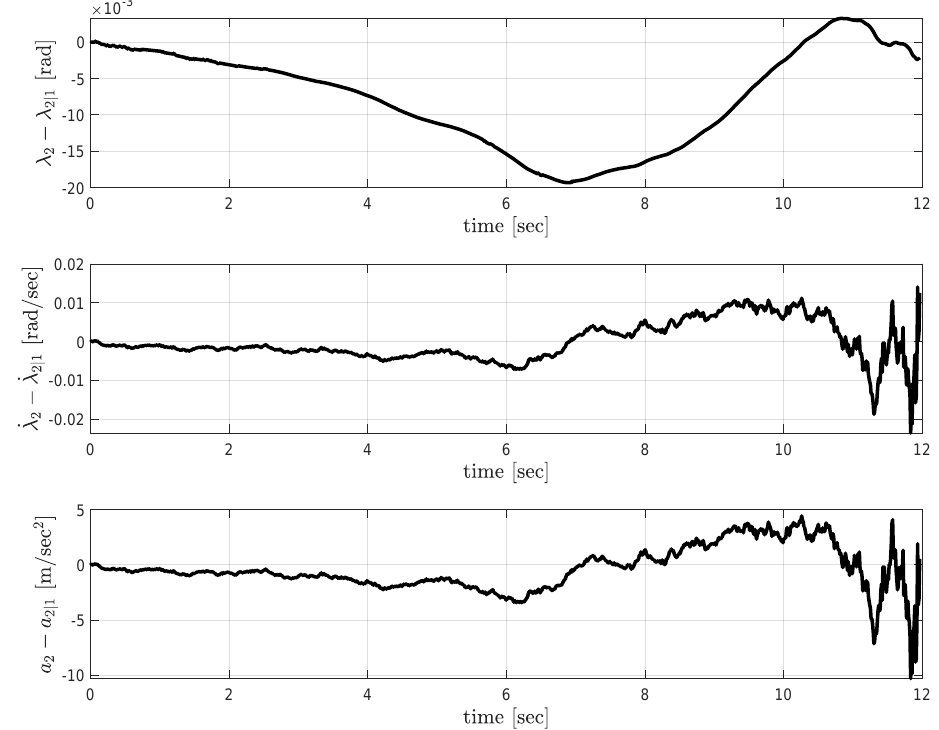
Figure 7. Decentralized cooperation: estimation error profiles ( top , middle ), and the correction command ( bottom ) computed by UAV 2